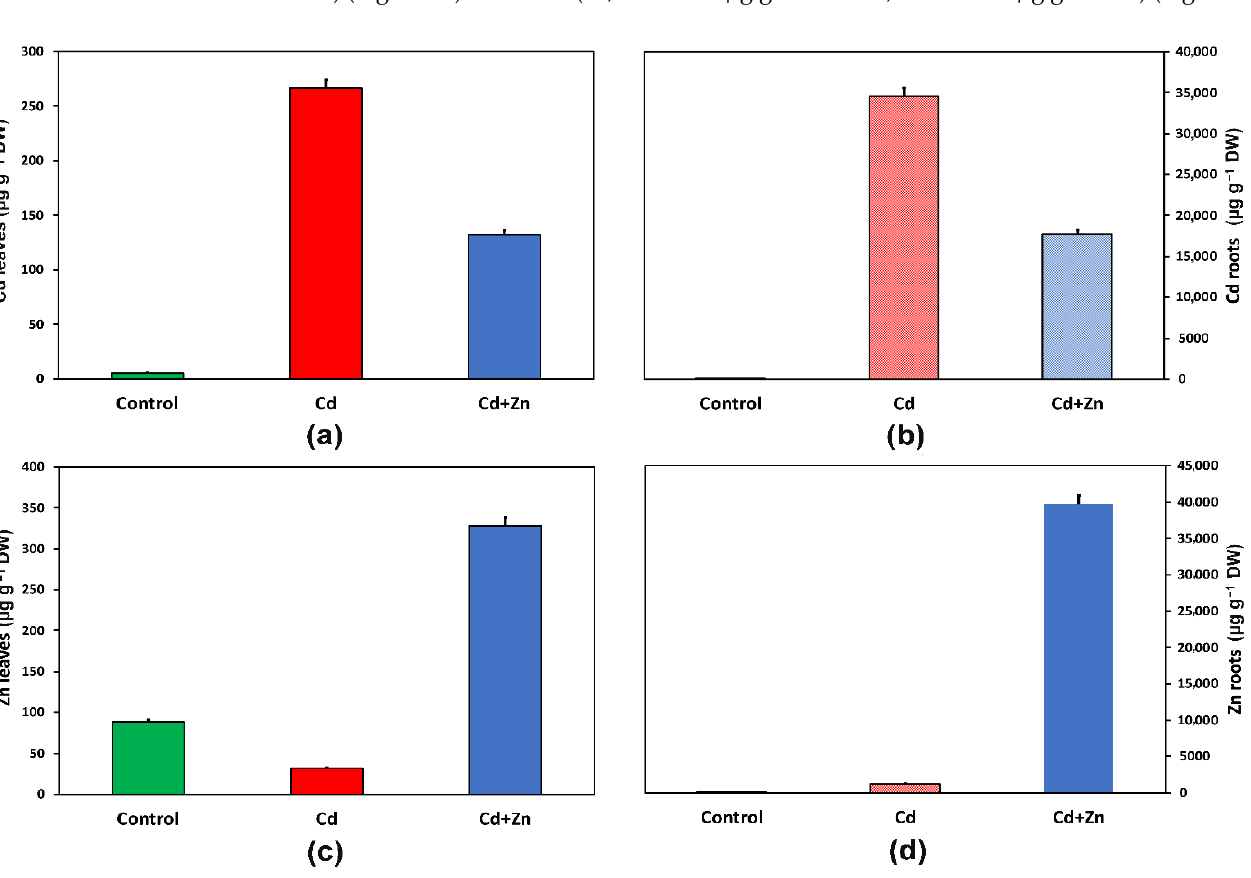
Figure 1. Changes in Cd 2+ accumulation in leaves ( a ) and roots ( b ) and Zn 2+ accumulation in leaves ( c ) and roots ( d ) in μ g g − 1 dry weight (DW) after eight days treatment of Salvia sclarea plants with control (nutrient solution), Cd 2+ (nutrient solu- tion +100 μ M Cd 2+ ), and Cd 2+ + Zn 2+ (nutrient solution +100 μ M Cd 2+ + 900 μ M Zn 2+ ). Error bars are standard deviations ( n =